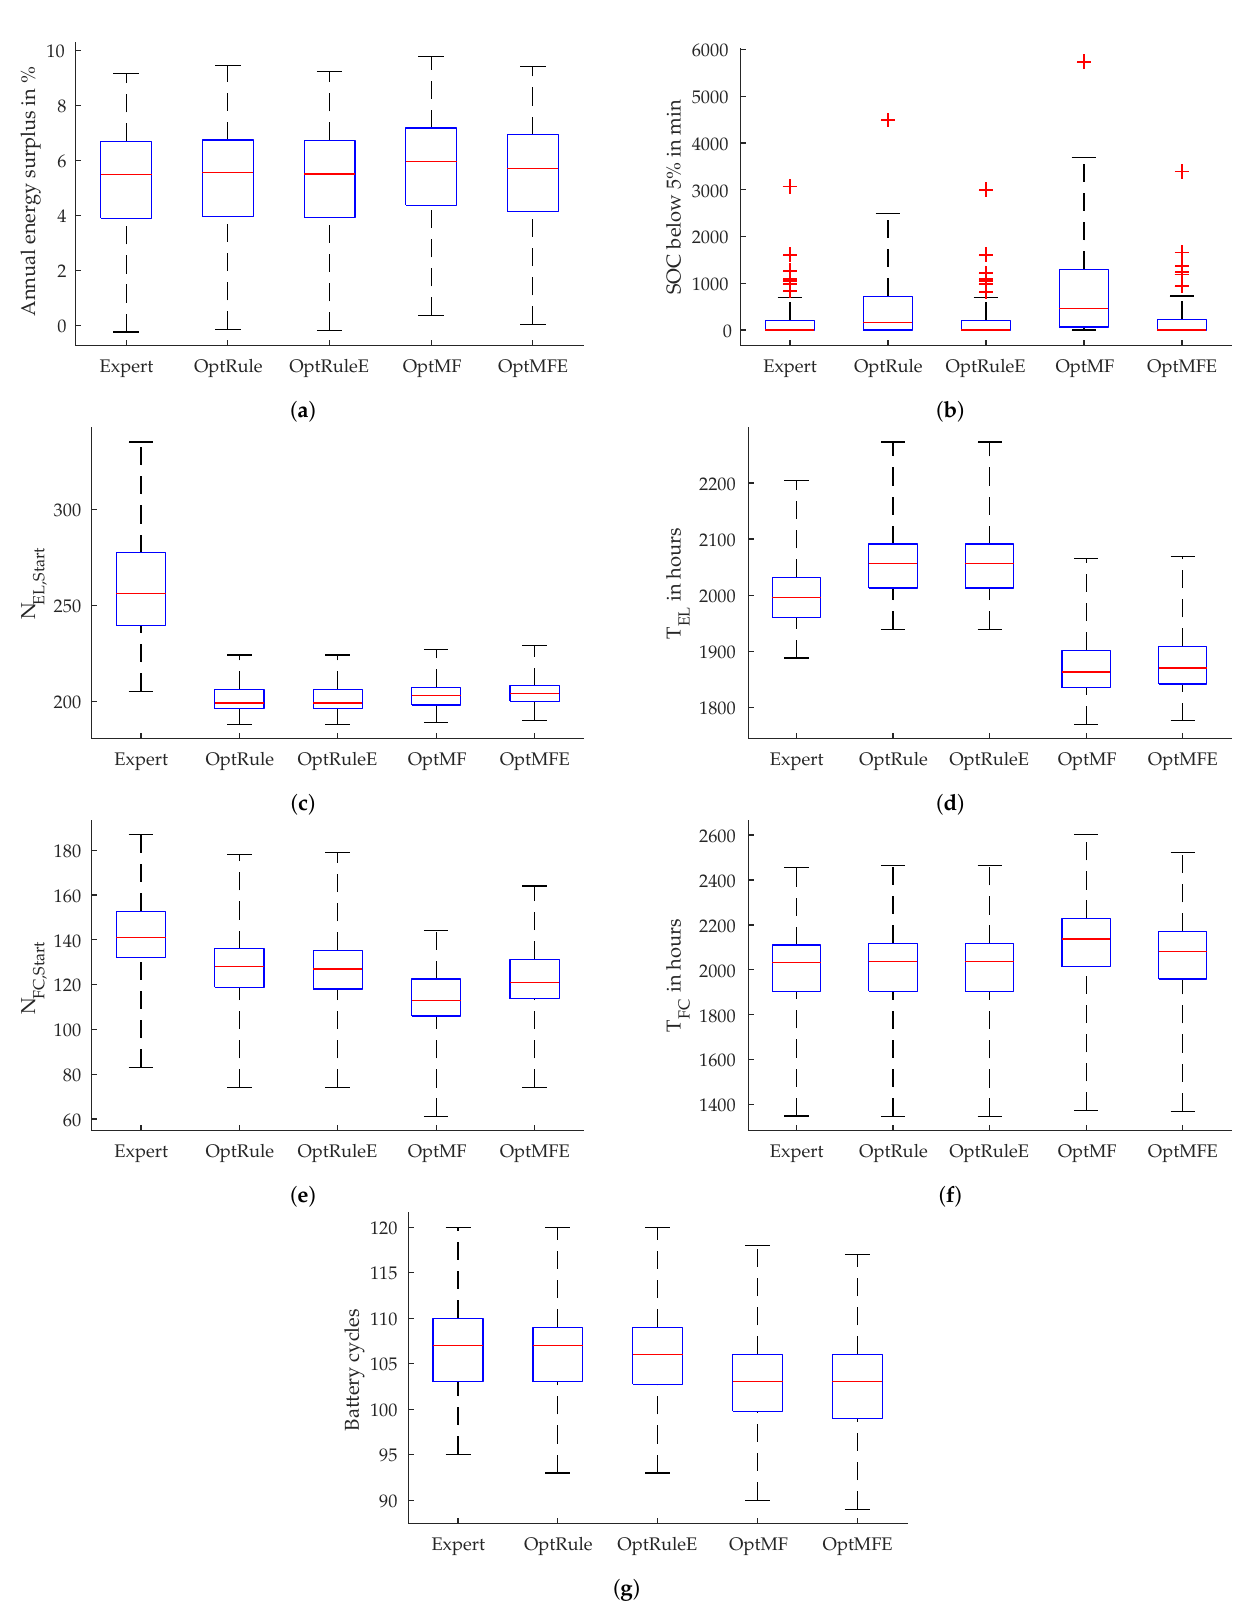
Figure 17. Performance indicators for several controller tunings. ( a ) Annual energy surplus; ( b ) time with low battery SOC; ( c ) number of electrolyzer starts; ( d ) electrolyzer operation time; ( e ) number of fuel cell starts; ( e ) fuel cell operation time; ( f ) fuel cell operation time; ( g ) equivalent number of full battery